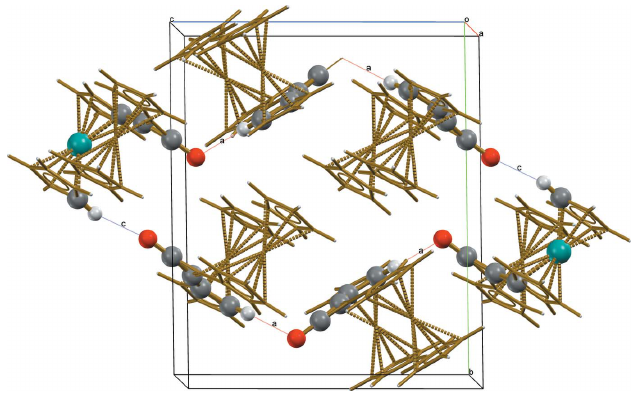
Figure 2 The crystal structure of the title compound, showing intermolecular C— H (cid:3)(cid:3)(cid:3) O interactions, forming graph-set motifs R 2 b and c axes.